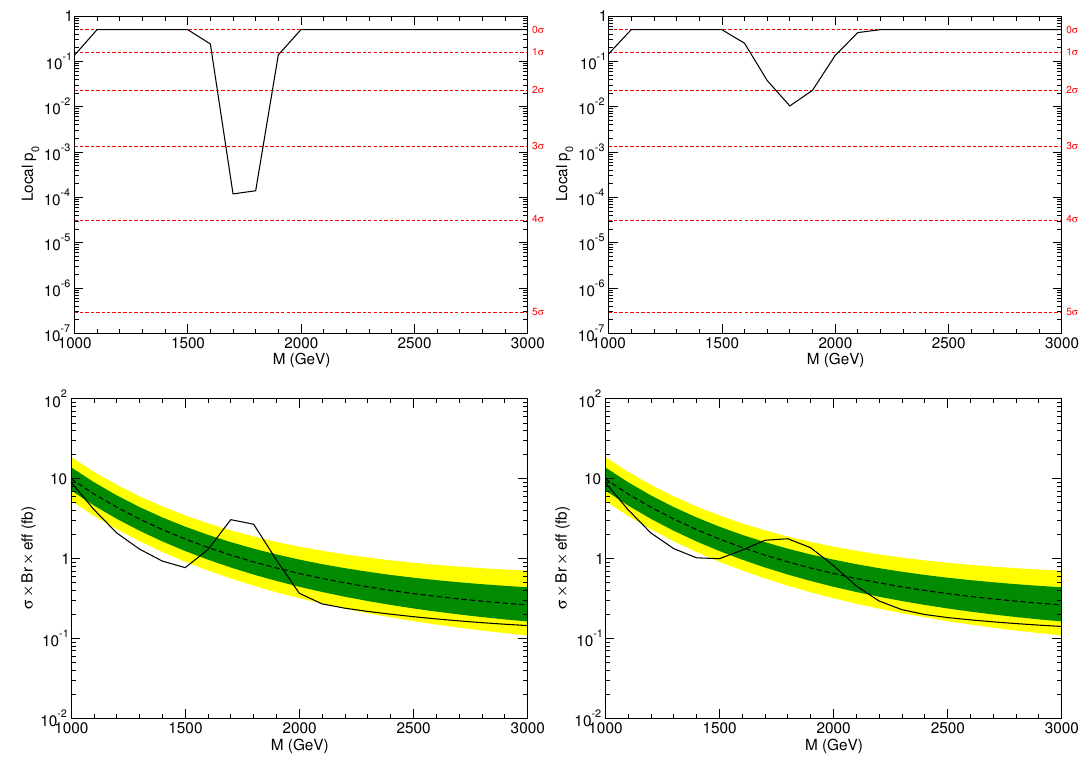
Figure 11 . Top: local p -values for the Asimov data, for the narrow (left) and wide (right) Gaussian shapes. Bottom: expected and observed limits for the Asimov data, for the narrow (left) and wide (right) Gaussian